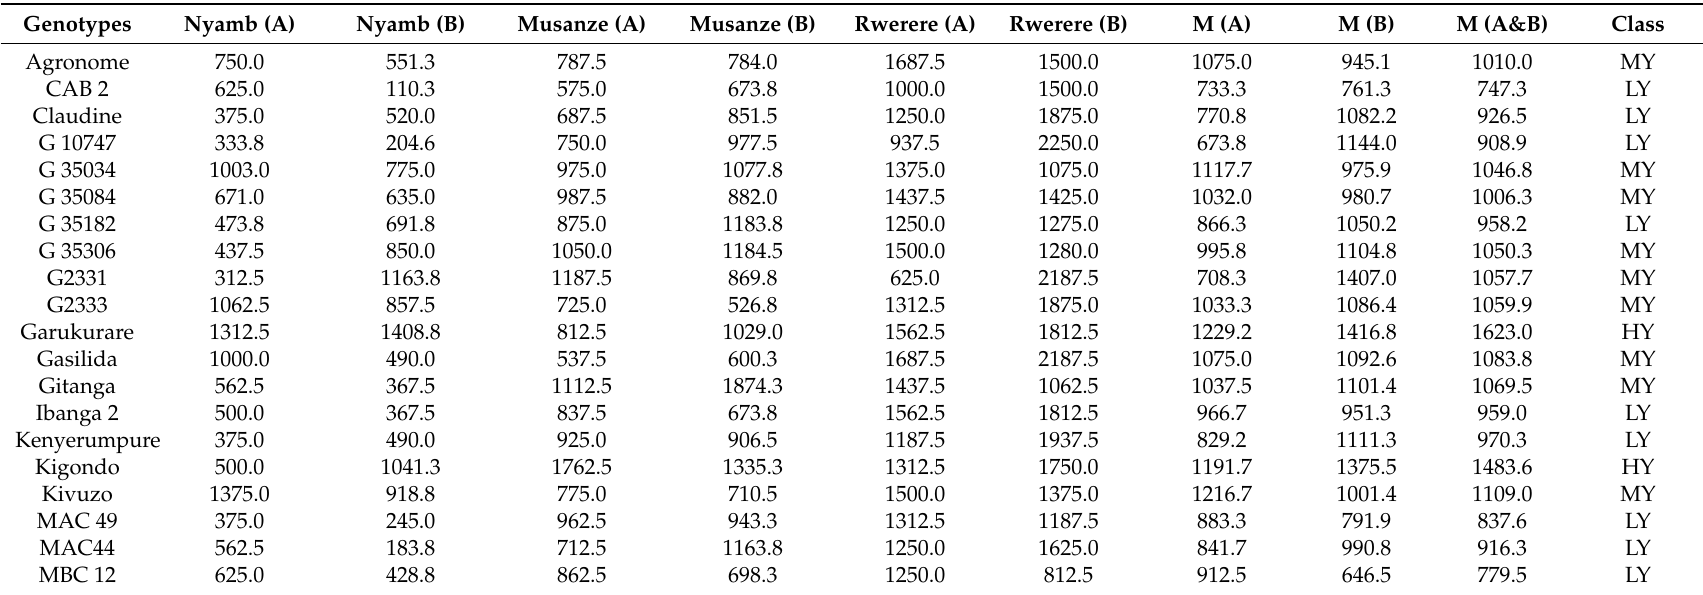
Table 8. Average yield (kg ha − 1 ) of 36 climbing bean genotypes tested in six environments in